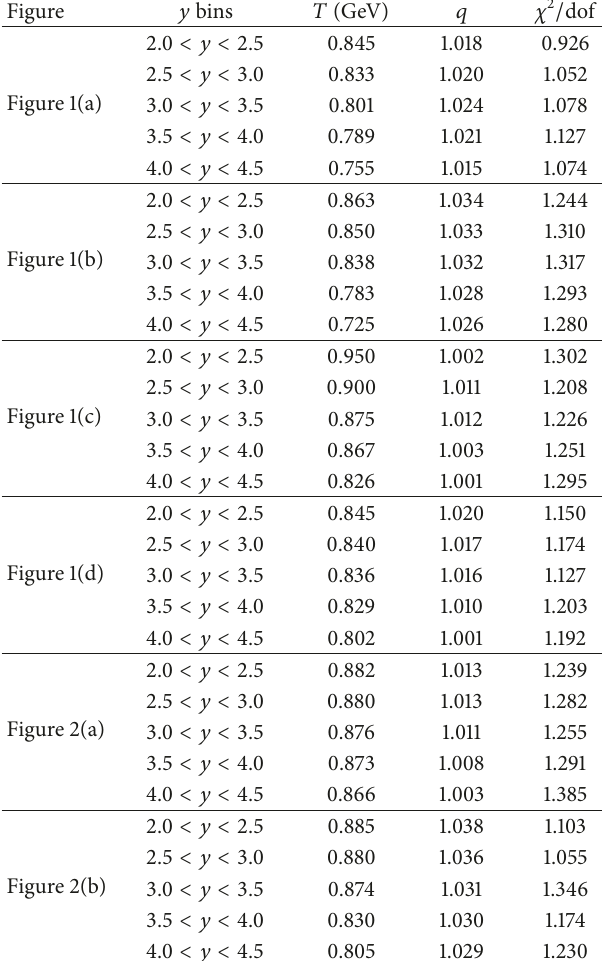
Table 1: Values of 𝑇 and 𝑞 used in Figures 1-2.